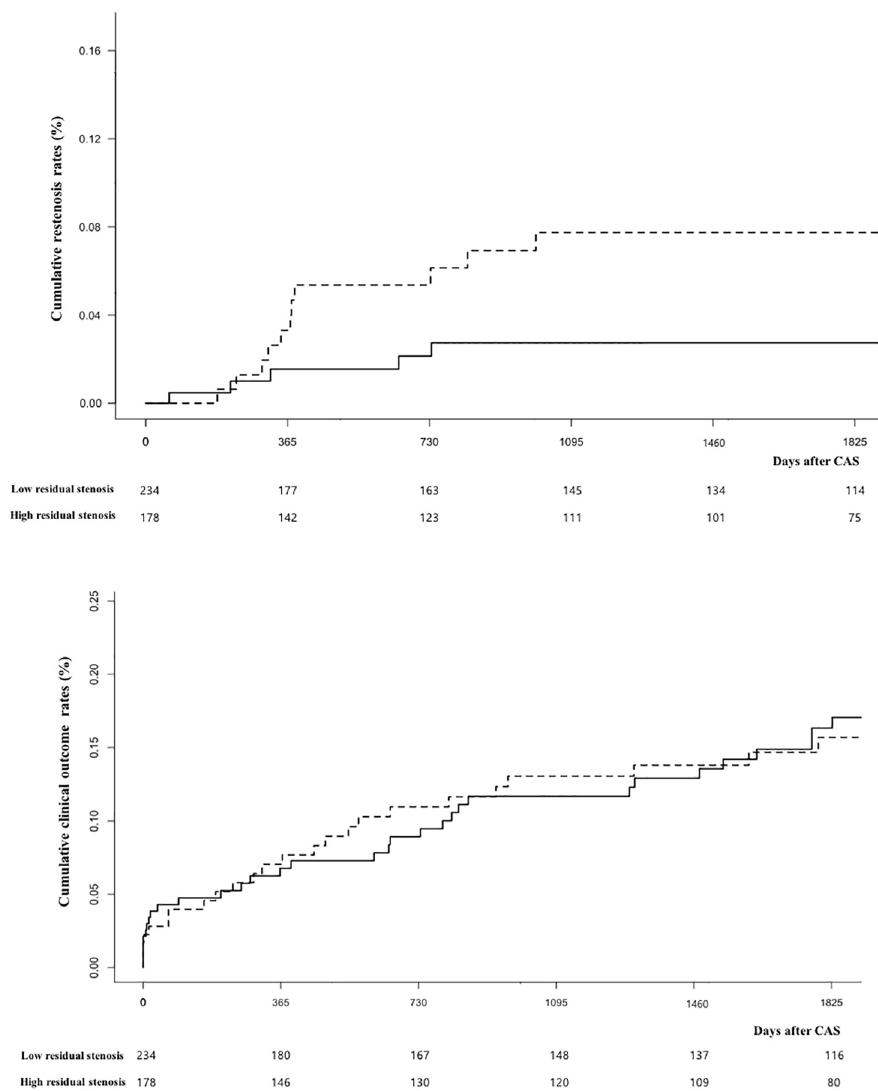
Fig 2. Kaplan-Meier survival curves of residual stenosis for hazards of restenosis (upper) and clinical outcome (lower). The P values determined by log-rank test were 0.047 (upper) and 0.86 (lower), respectively. The solid line indicates low residual stenosis, and the dotted line indicates high residual stenosis.